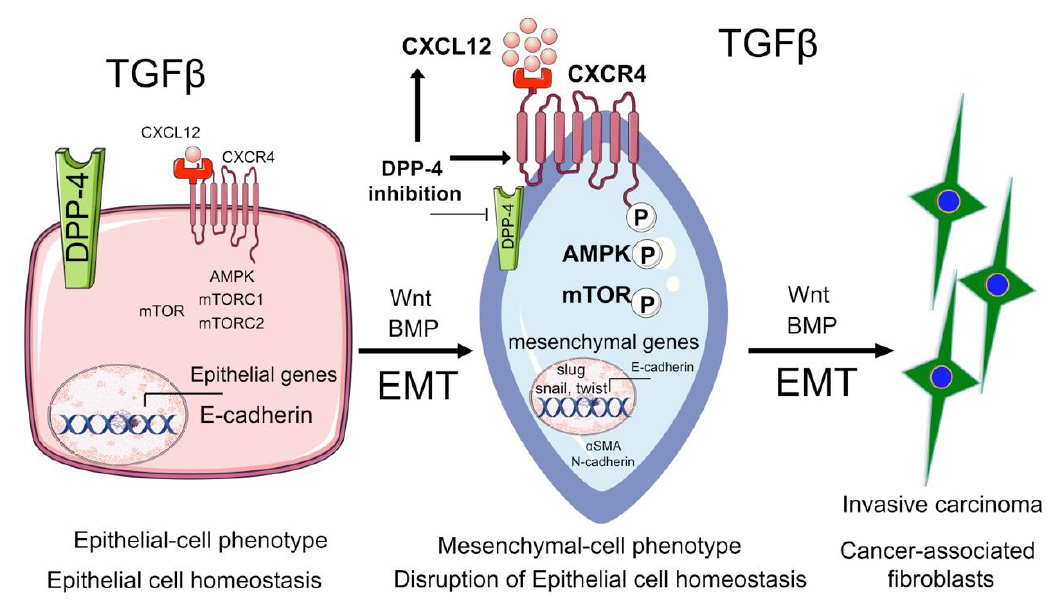
Figure 1. Role of DPP4 in cancer biology. In normal diabetic epithelial cells, DPP4 is highly expressed and is associated with lower levels of the CXCL12 / CXCR4 / mTOR / EMT axis. Inhibition of DPP4 induces TGF- β - independent activation of CXCL12 / CXCR4 / mTOR / EMT axis, promotes the formation of cancer-associated fibroblasts and accelerates cancer